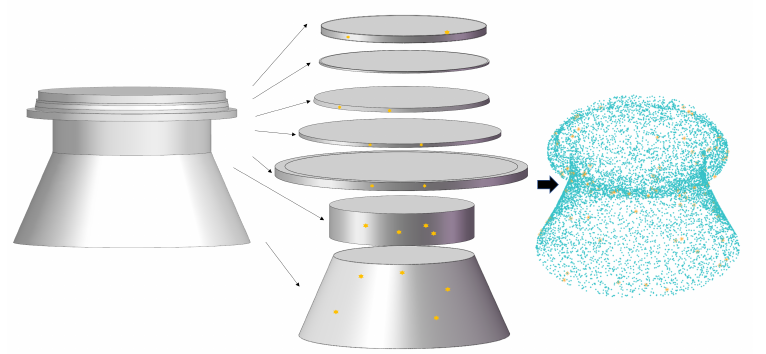
Figure 6. The CAD model is divided into feature regions, and some data points are selected as seed